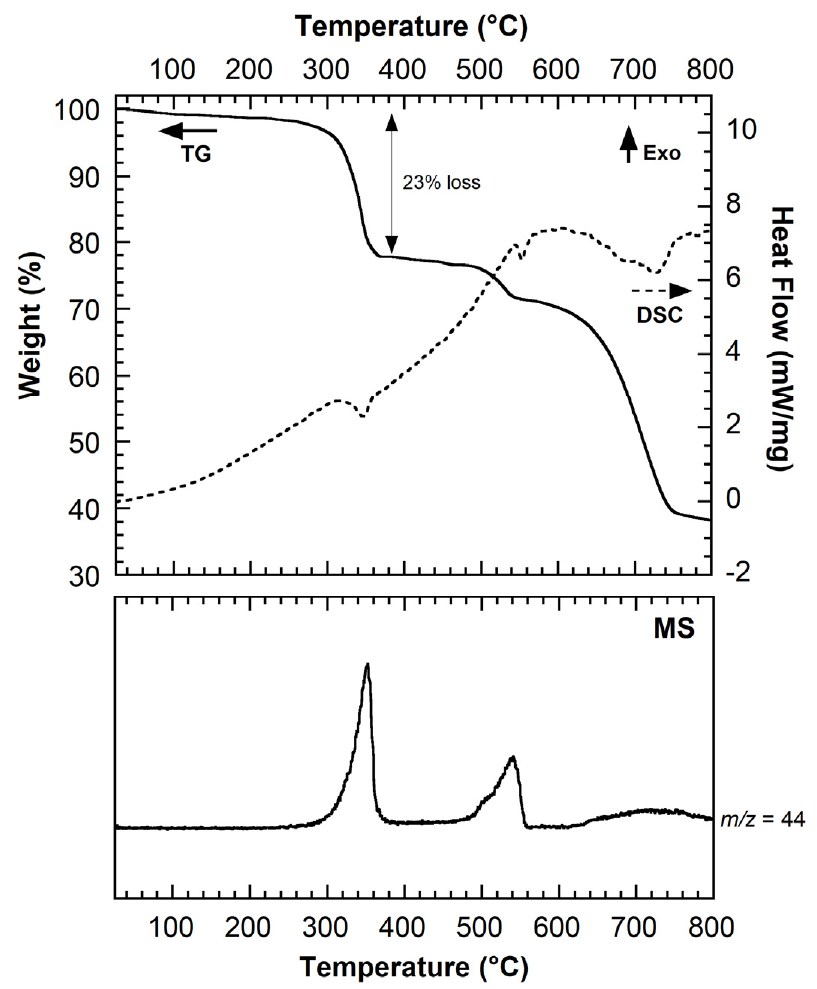
Figure 2. Thermal analyses (TG-DSC-MS) of (Li 2 )(Li,H)-o-DHT recorded under argon at a heating rate of 5 °C.min − 1 ( m / z = 44 is ascribed to CO 2 evolution).